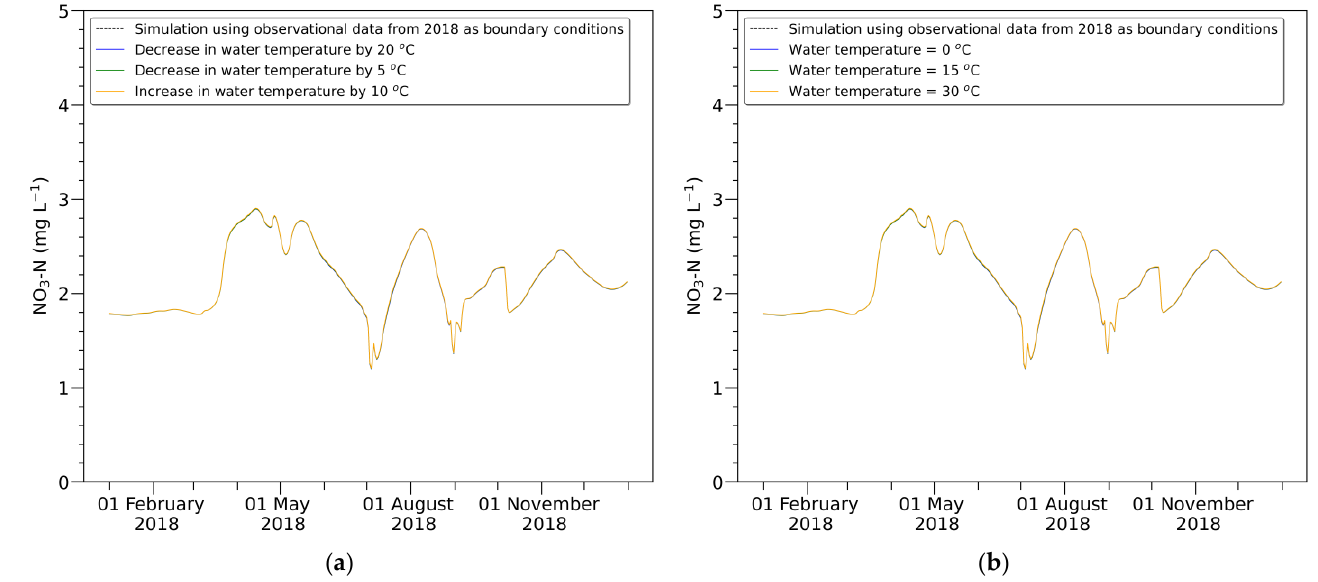
Figure 12. Changes in the NO 3 -N concentration in cross section 416 caused by variations in water temperature at the upstream boundary. The black graphs show results simulated using the observational data from 2018 as boundary conditions. ( a ) Changes in the NO 3 -N concentration by a decrease or increase in water temperature (Scenarios 43 – 45); ( b ) changes in the NO 3 -N concentration by constant water temperature (Scenarios 46 – 48).